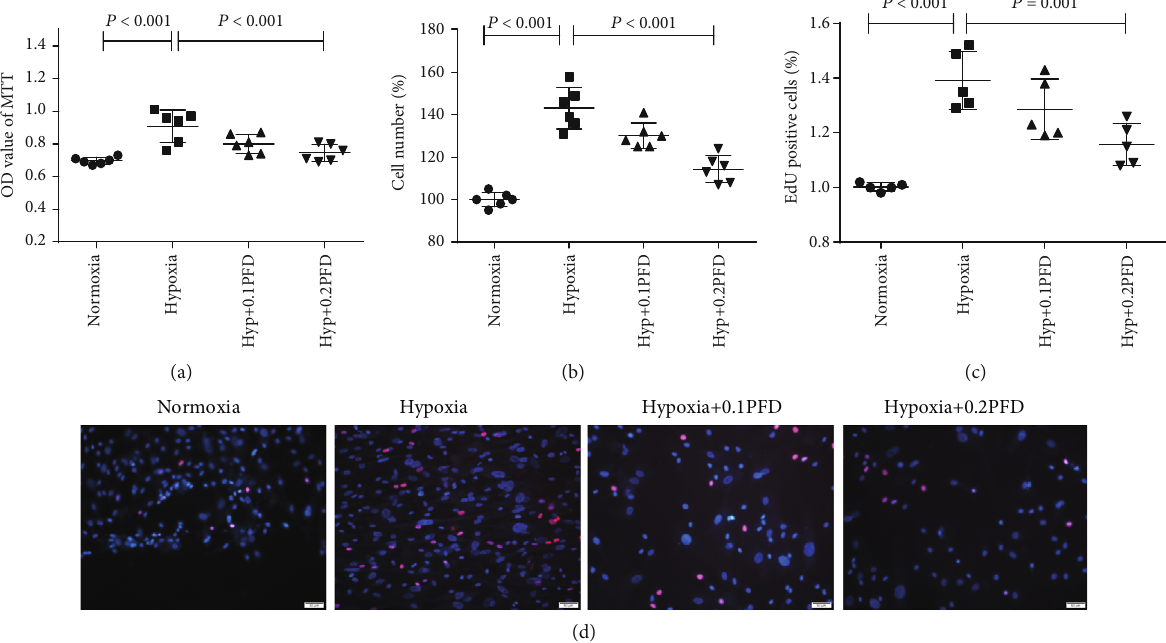
Figure 1: PFD reduced the proliferation of HPAAFs in hypoxia. HPAAFs were stimulated by PFD before hypoxia, and then, cell proliferation was assessed by MTT, cell counting, and EdU. (a, b) PFD decreased the hypoxia-induced HPAAF proliferation assessed by MTT and cell counting ( n = 5 ). (c, d) PFD decreased the hypoxia-induced HPAAF proliferation assessed by EdU ( n = 5 ). Red: EdU; blue: cell nucleus. Hyp: hypoxia; OD: optical density; PFD: pirfenidone; HPAAFs: human pulmonary arterial adventitial fi